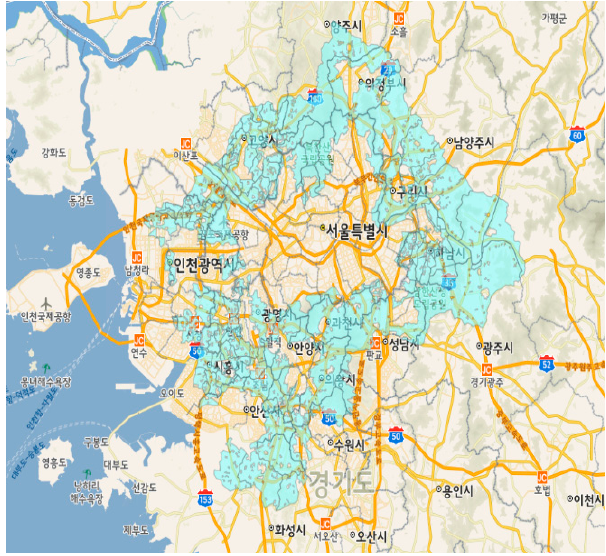
Figure 5. Seoul metropolitan area green belt.